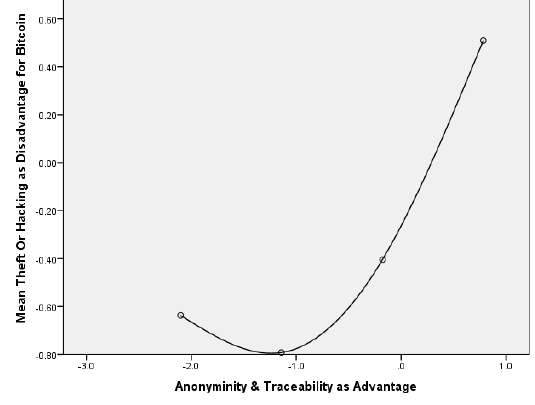
Figure 10. Mean plot of Theft and hacking with anonymity and